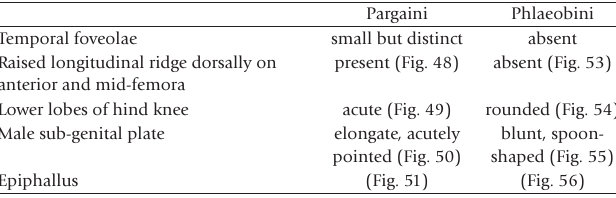
Table 2. Differentiation between Phlaeobini and